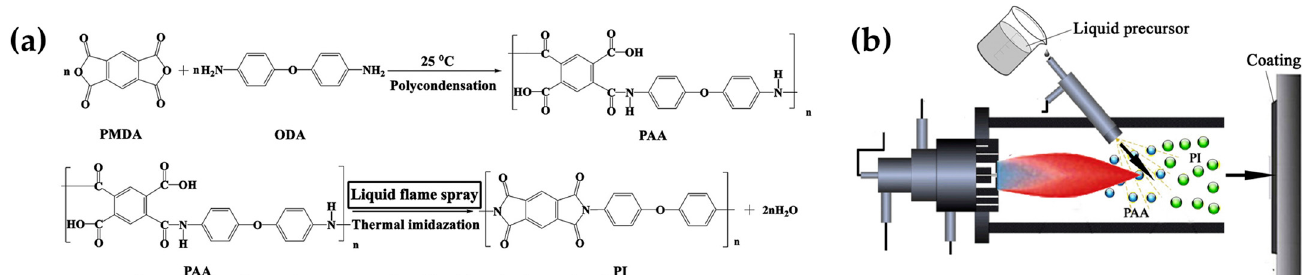
Figure 22. Synthetic pathway of polyimide ( a ) by liquid flame spray approach ( b ). Reprinted with permission from Ref. [75]. Copyright 2017, Y. Liu, Materials & Design, Elsevier.